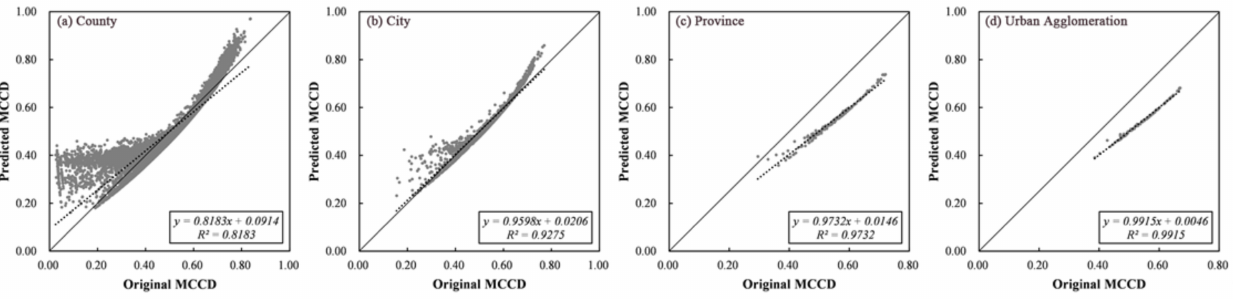
Figure 11. Scatter plot between the original and predicted MCCD at different